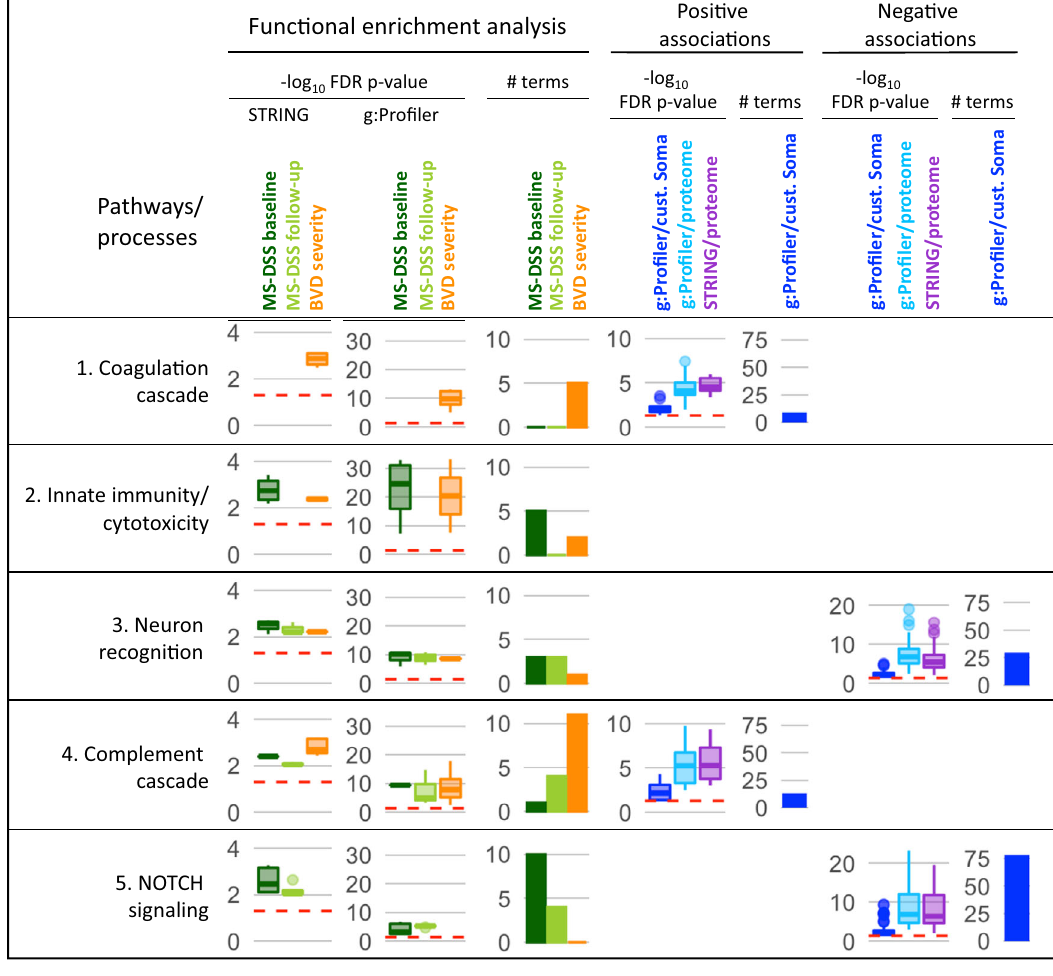
Fig. 5 | Molecular pathways associated with MS severity. One-thousand three- hundred fi ve healthy volunteer (HV) age- and sex-adjusted SOMAmers were cor- relatedwiththethreemultiplesclerosis(MS)severityoutcomes — multiplesclerosis diseaseseverityscore(MS-DSS)atbaseline(darkgreen),MS-DSSatfollow-up(light green), and brain volume de fi cit (BVD) severity (orange). Spearman correlation coef fi cients were used for the Functional enrichment analysis (FEA) in the STRING database. Enriched pathways and processes with false-discovery rate (FDR)-adjus- ted p -value<0.05weregroupedinto fi vemaincategories,andtheboxplotsforthe p -values of individual processed are displayed. The validity of the fi ndings was tested in g:Pro fi ler database, where the same list of 1305 genes ordered by the increasing p -value was inputted for the FEA using the g:GOSt tool. The boxplots of FDR-adjusted p -values are shown. # term counts the number of processes identi fi ed for each category and outcome. Biomarkers signi fi cantly (FDR-adjusted